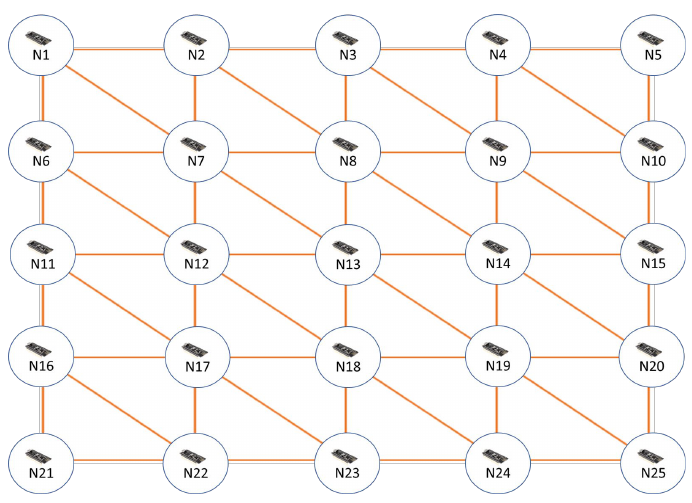
Figure 6. The 3-way grid network.